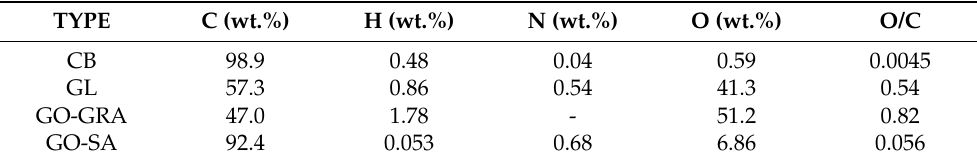
Table 1. Elemental composition of GL materials and selected benchmark GRMs. GL precursor (CB) is also